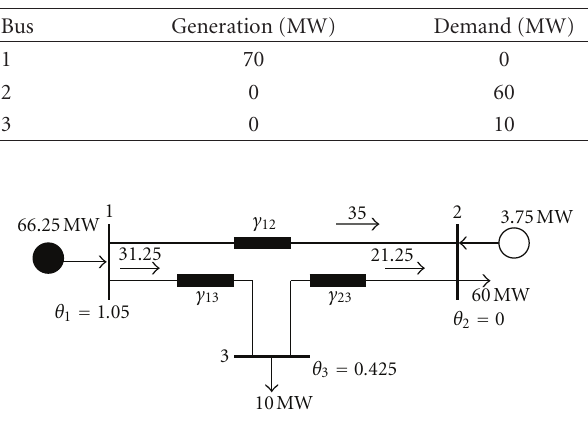
Table 2: Generation and demand data of the 3-buse system.